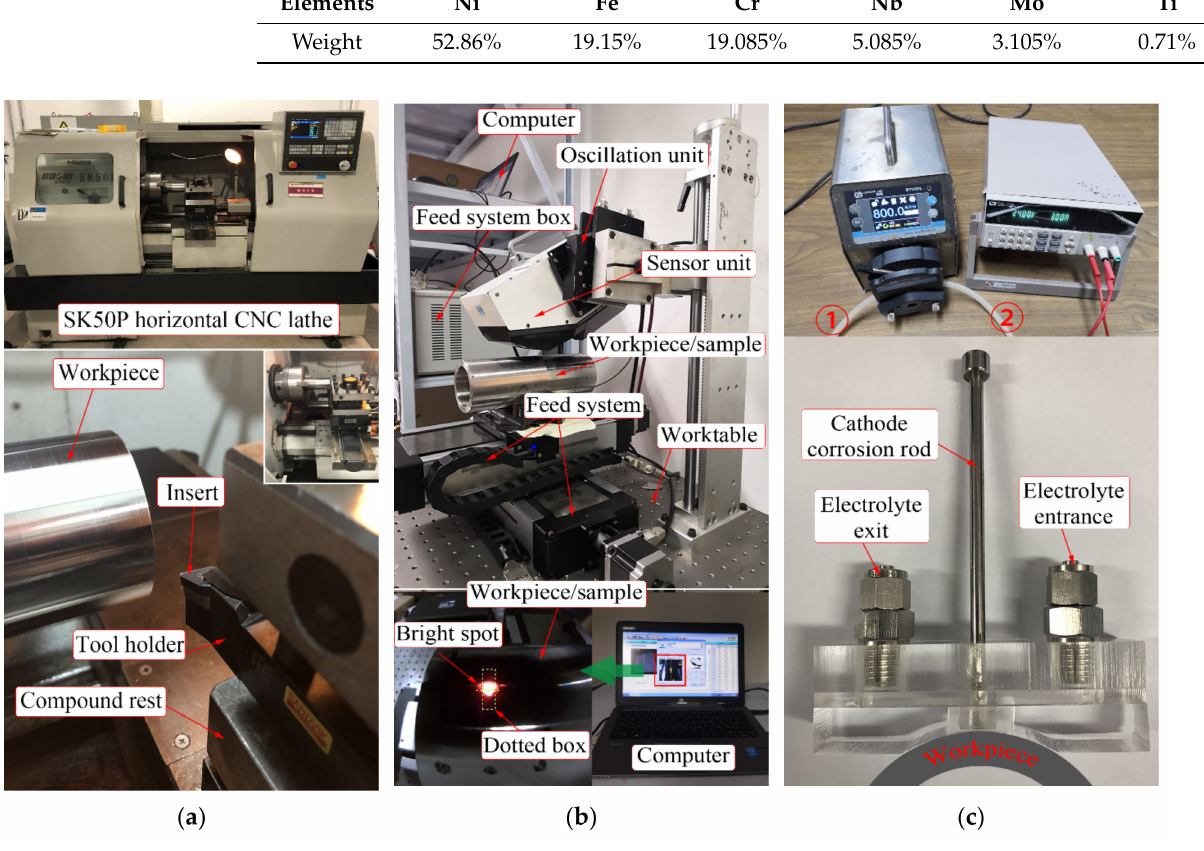
Figure 2. ( a ) The turned experimental details, ( b ) the approach of residual stress measurement by X-ray diffractometer, and ( c ) the electrolytic corrosion